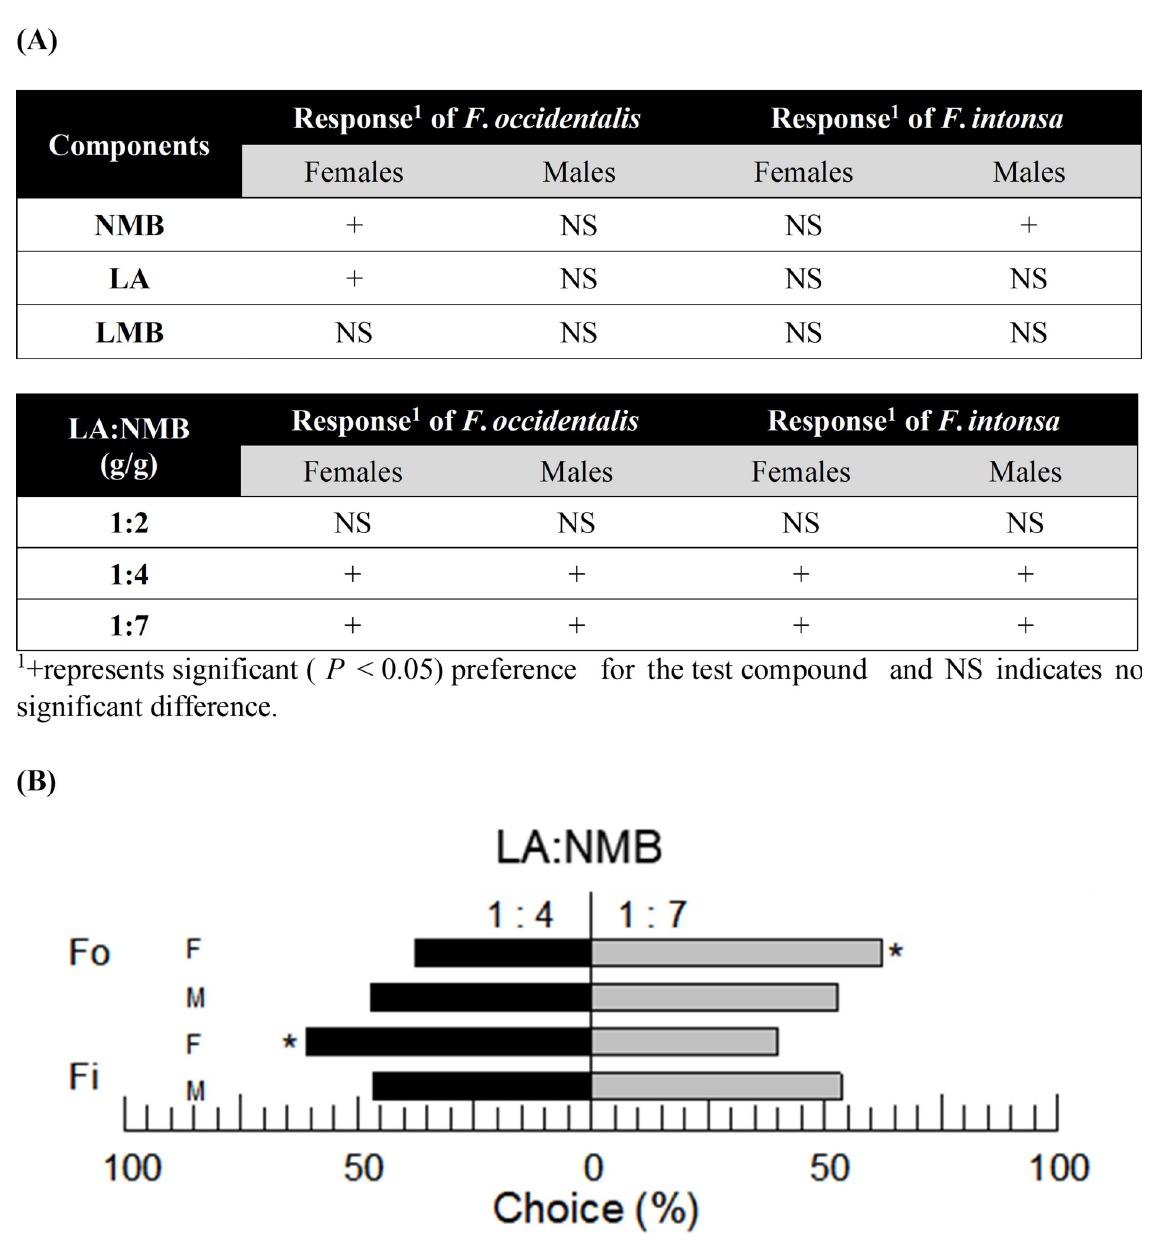
Fig 1. Differential preference analysis of two flower thrips ( F . occidentalis and F . intonsa ) for aggregation pheromone using a Y-tube olfactometer. (A) Screening of active components and mixture ratios in the aggregation pheromone. The pheromone components were identified as LA (lavandulyl acetate), LMB (lavandulyl methylbutanoate), and NMB (neryl methylbutanoate). (B) Choice tests of the thrips against two pheromone blends. Each response (experimental unit) used 20 adults ( < 3-days-old after emergence). Each treatment was replicated four times. The detailed data are presented in S1